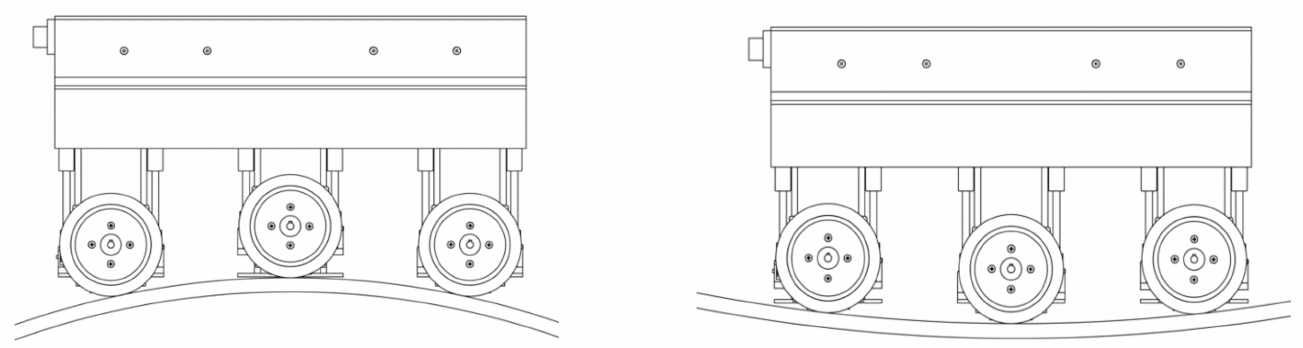
Figure 6. Obstacle crossing state: ( a ) shortest length, ( b ) longest length, ( c ) contact, ( d ) lift.